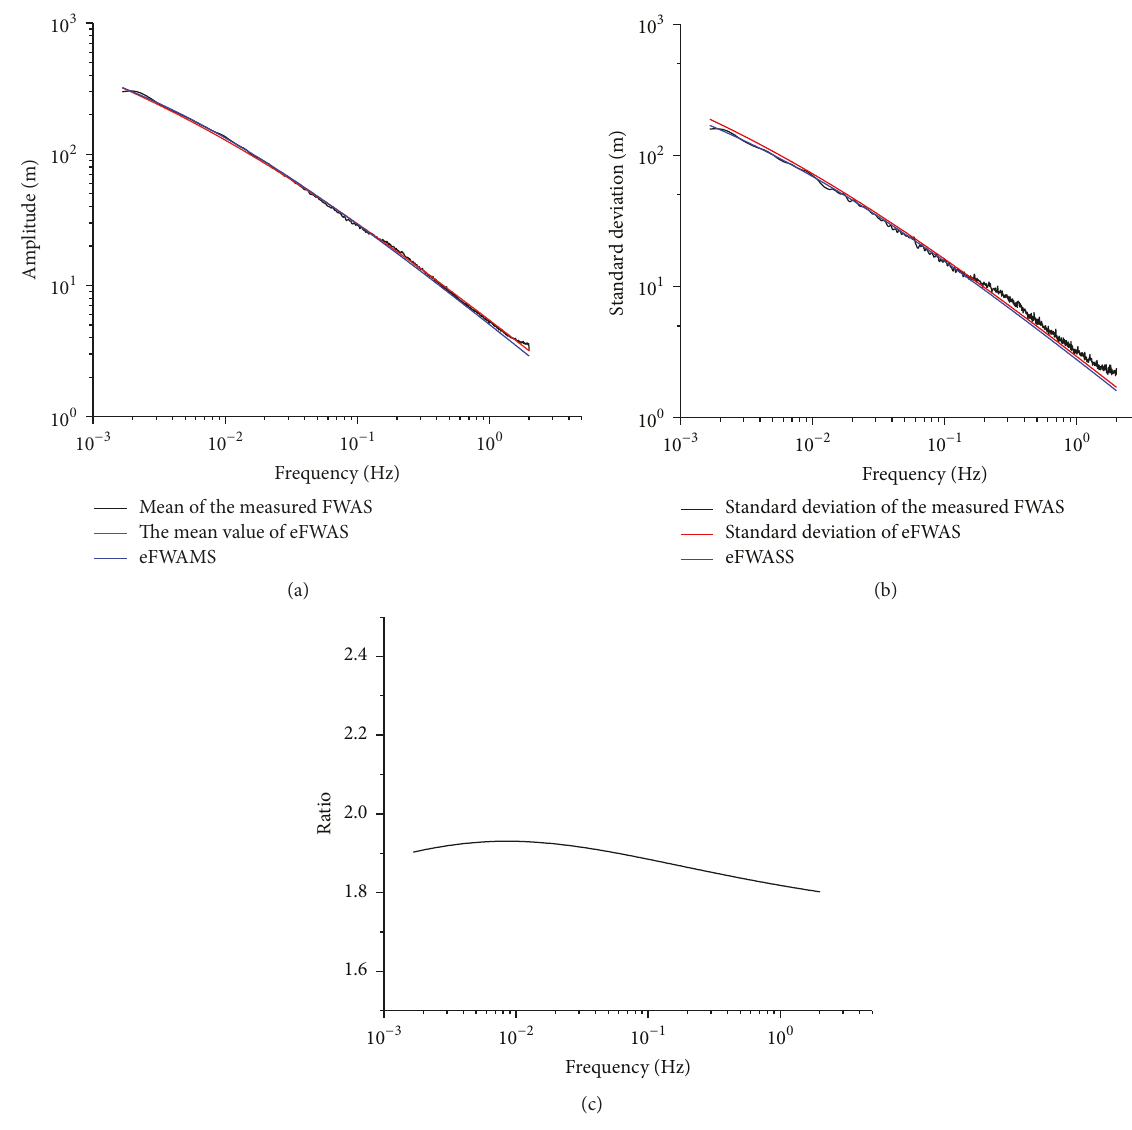
Figure 11: Comparison of results for eFWAMS and